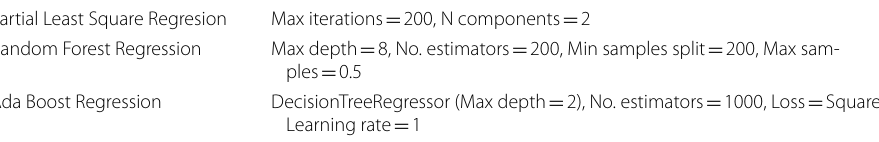
Table 3 Hyperparameters chosen by grid search for the base regressors (Additional file 1: Table